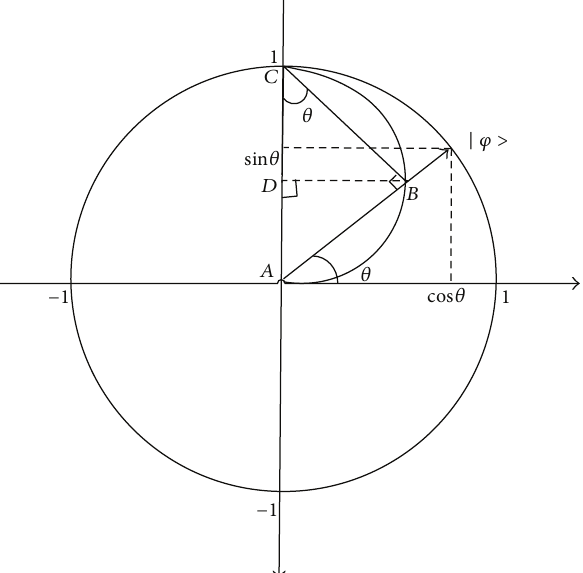
Figure 6: Schematic diagram of the qubit probability amplitude